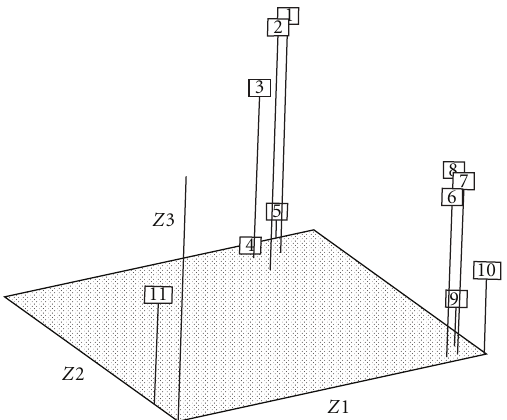
Figure 3: Patterns of relationships of the 11 populations revealed by the principal component analysis based on short primer DALP data. Proportion of the total variance explained by the first three principal components (PCs) is 78.31%: PC1 = 41.19%; PC2 = 27.42%; PC3 = 9.70% (Rice infesting populations of N. lugens : 1 = UPM1, 2 = TK1, 3 = MK1, 4 = PK1 and 5 = SB1; Grass infesting populations of N. lugens : 6 = UPM2, 7 = TK2, 8 = MK2, 9 = PK2, and 10 = SB2; An out group, N. bakeri , 11 =